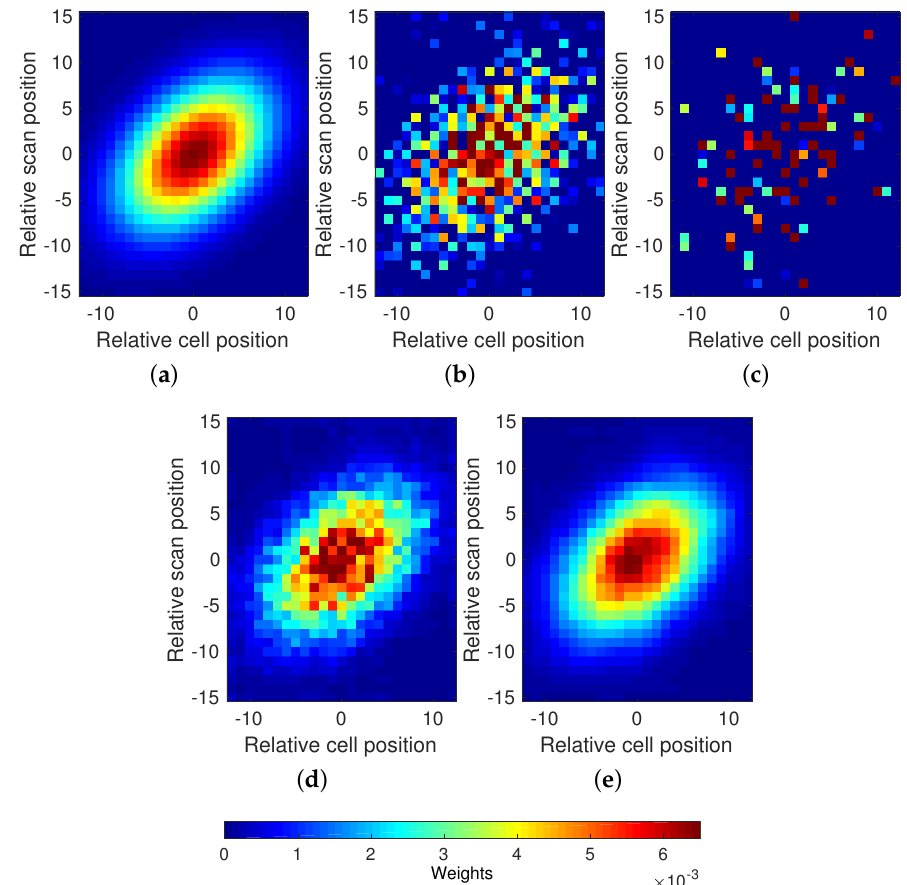
Figure 5. The results using simulated AMSR-E measurements. ( a ) Imposed footprint; ( b ) Algorithm 1 output with ( R , n ) = (1; 250,000); ( c ) ( R , n ) = ( 1;2000 ) and ( d ) ( R , n ) = ( 2000;2000 ) ; ( e ) is achieved by applying a 4 × 4 moving average to ( d ).